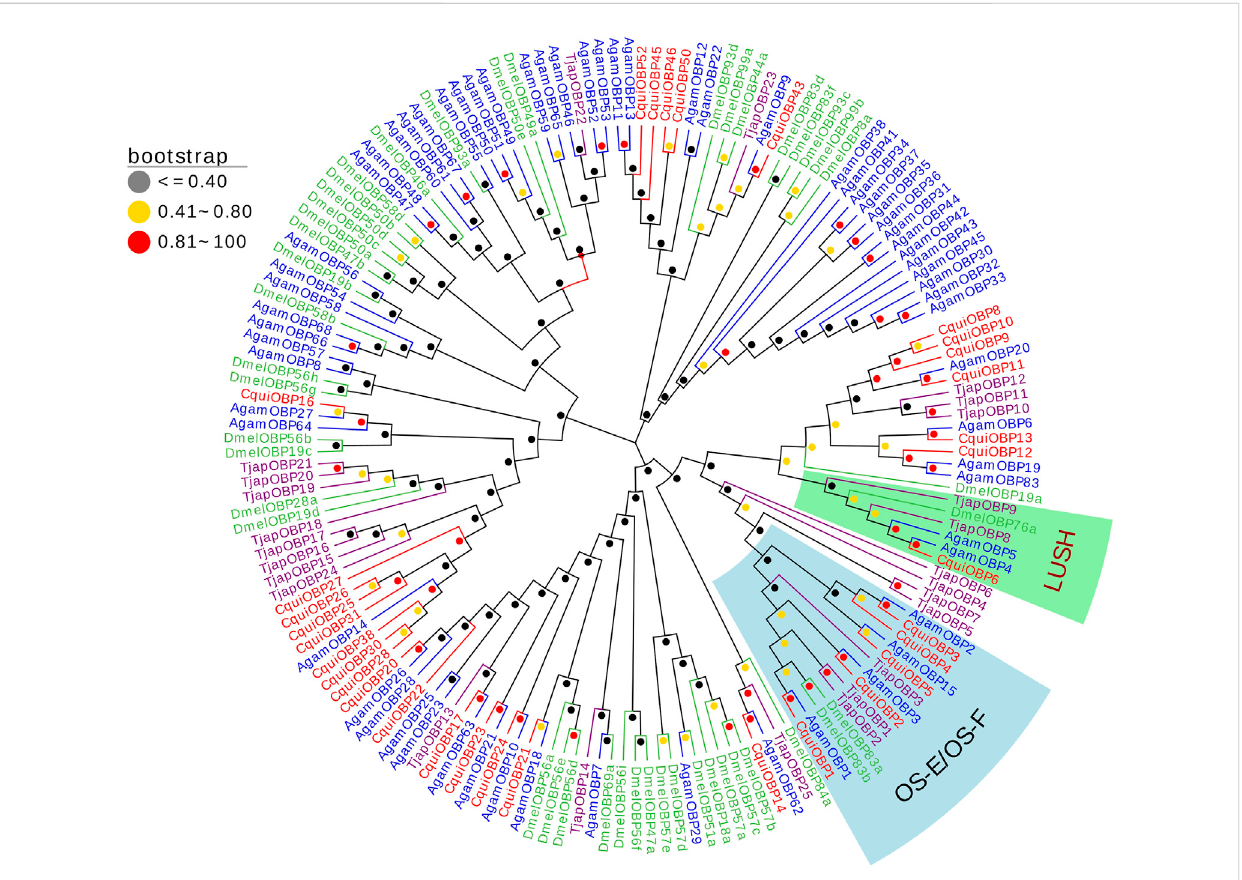
FIGURE 1 The NJ phylogenetic analysis of OBPs in T. japonensis , C. quinquefasciatus , A. gambiae , and D. melanogaster . The LUSH group and OS-E/OS-F group are